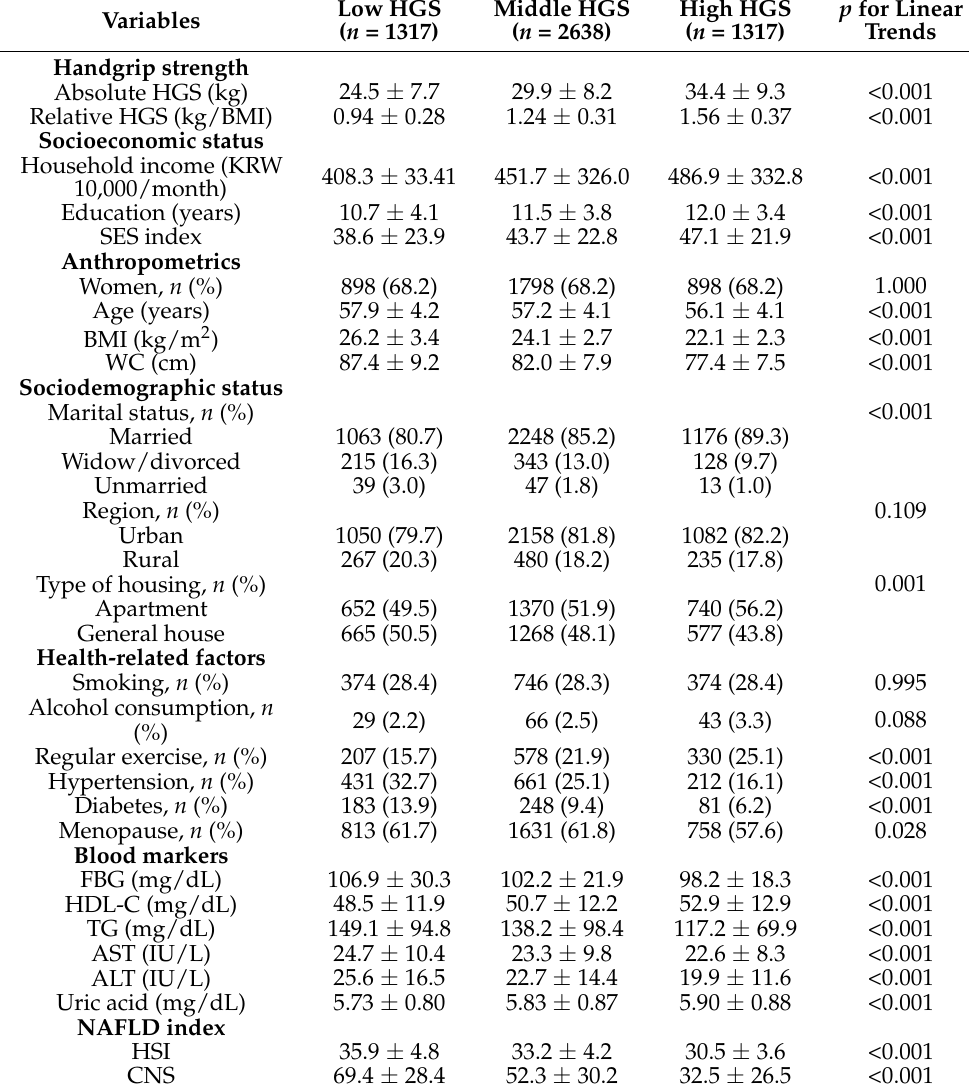
Table 3. Descriptive statistics of the measured parameters according to the relative HGS